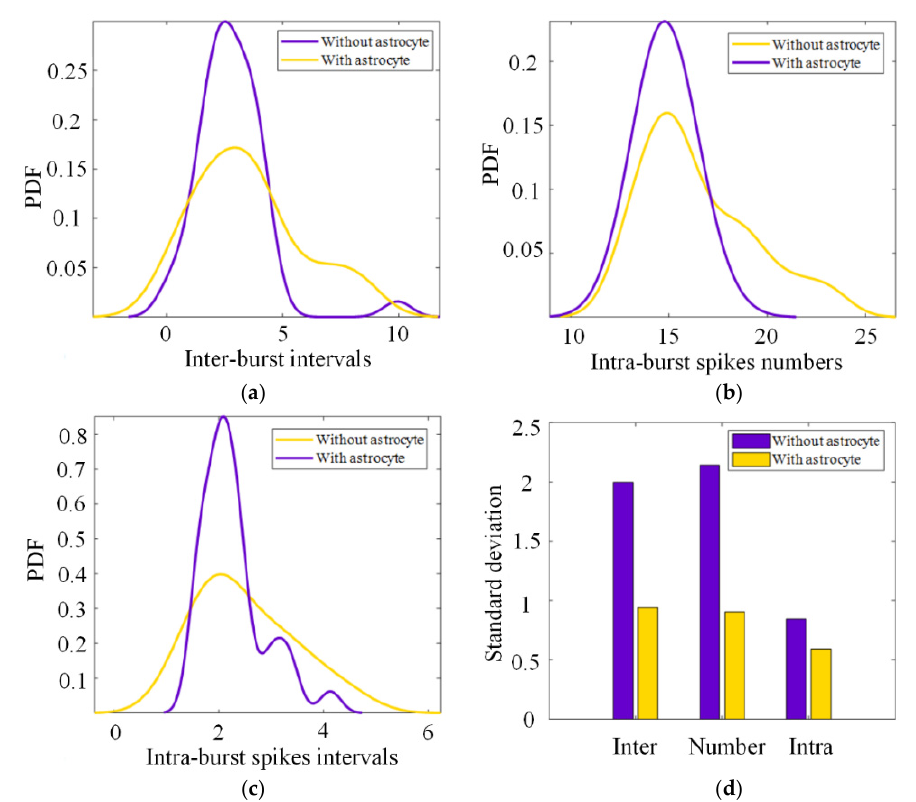
Figure 4. Probability density function and variance statistics of the output of CPG with or without astrocytes. ( a ) The probability density function of the inter ‐ burst intervals; ( b ) The probability density function of the intra ‐ burst spikes numbers; ( c ) The probability density function of the intra ‐ burst spikes intervals; ( d ) Variance statistics of the inter ‐ burst intervals, the intra ‐ burst spikes numbers, and the intra ‐ burst spikes intervals.